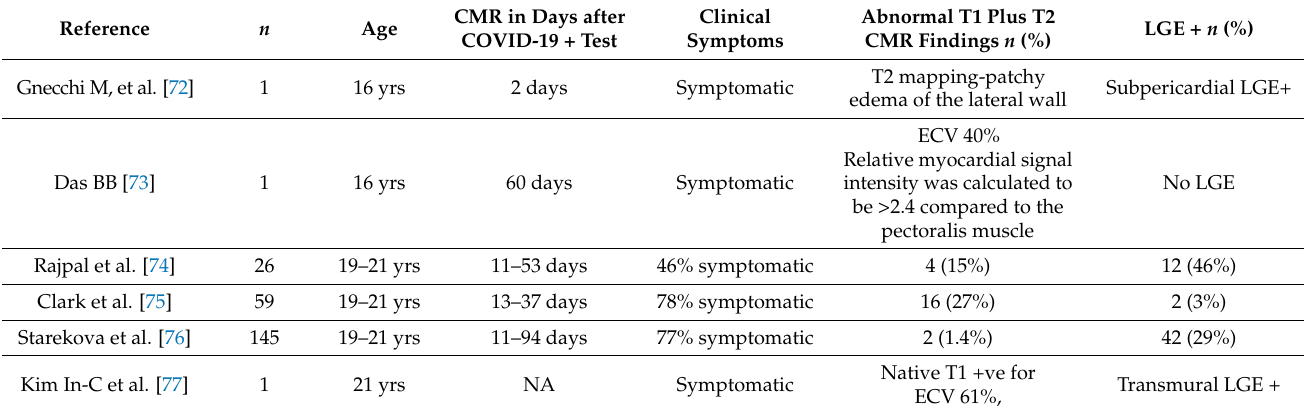
Table 2. CMR findings in children and young adults with COVID-19-associated